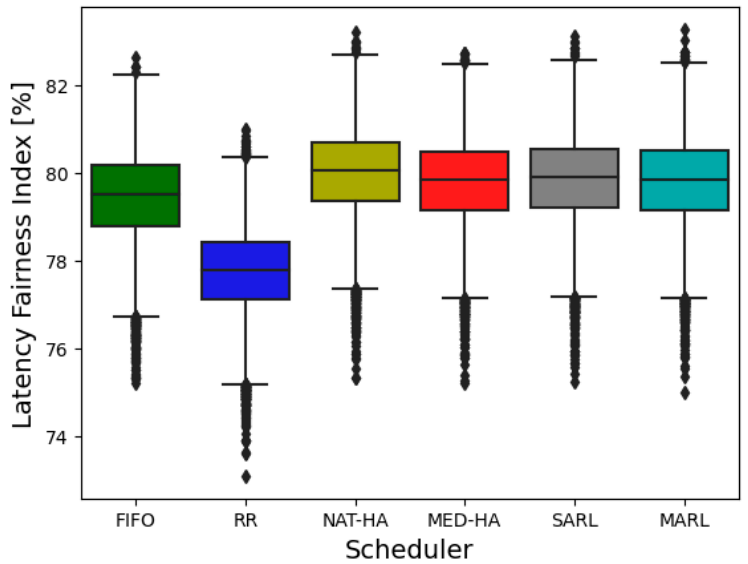
24 of 28 Figure 19. Moving average of maximum E2E latency per scheduler when random flows are gener- ated in topology 2. Figure 20 and Table 12 show the latency fairness index of each scheduler in % units. The latency fairness index was obtained for 10,000 episodes for each episode. In terms of average latency fairness, NAT-HA was the best, followed by SARL, MED-HA, MARL, FIFO, and RR in order of performance. As with the maximum E2E latency results, MED- HA and RL-based schedulers had similar latency fairness indices. However, NAT-HA produced better results than MED-HA and the RL-based scheduler because topology 2 is an environment in which E2E latency diverges and packets accumulate in queues. In to- pology 2, only packets with the same number of remaining hops content, so there is no difference in the maximum E2E latency of NAT-HA or other proposed schedulers. If each queue has a packet with the maximum estimated delay, MED-HA or an RL-based sched- uler serves random queues. However, at this time, the estimated delay of HoQ may be different. NAT-HA is advantageous in terms of latency fairness because it determines the order of packet service considering only HoQ. Compared to the proposed schedulers, FIFO and RR have an average latency fairness index of 0.5% and 2% smaller, respectively. The reason why the difference with FIFO is small is that there is no large performance difference from the scheduler proposed by the node connected to the bottleneck link for the same reason as NAT-HA. However, the average latency fairness index is smaller than that of the proposed scheduler due to performance differences in other nodes. Table 12. Latency fairness in topology 2 with random flow.